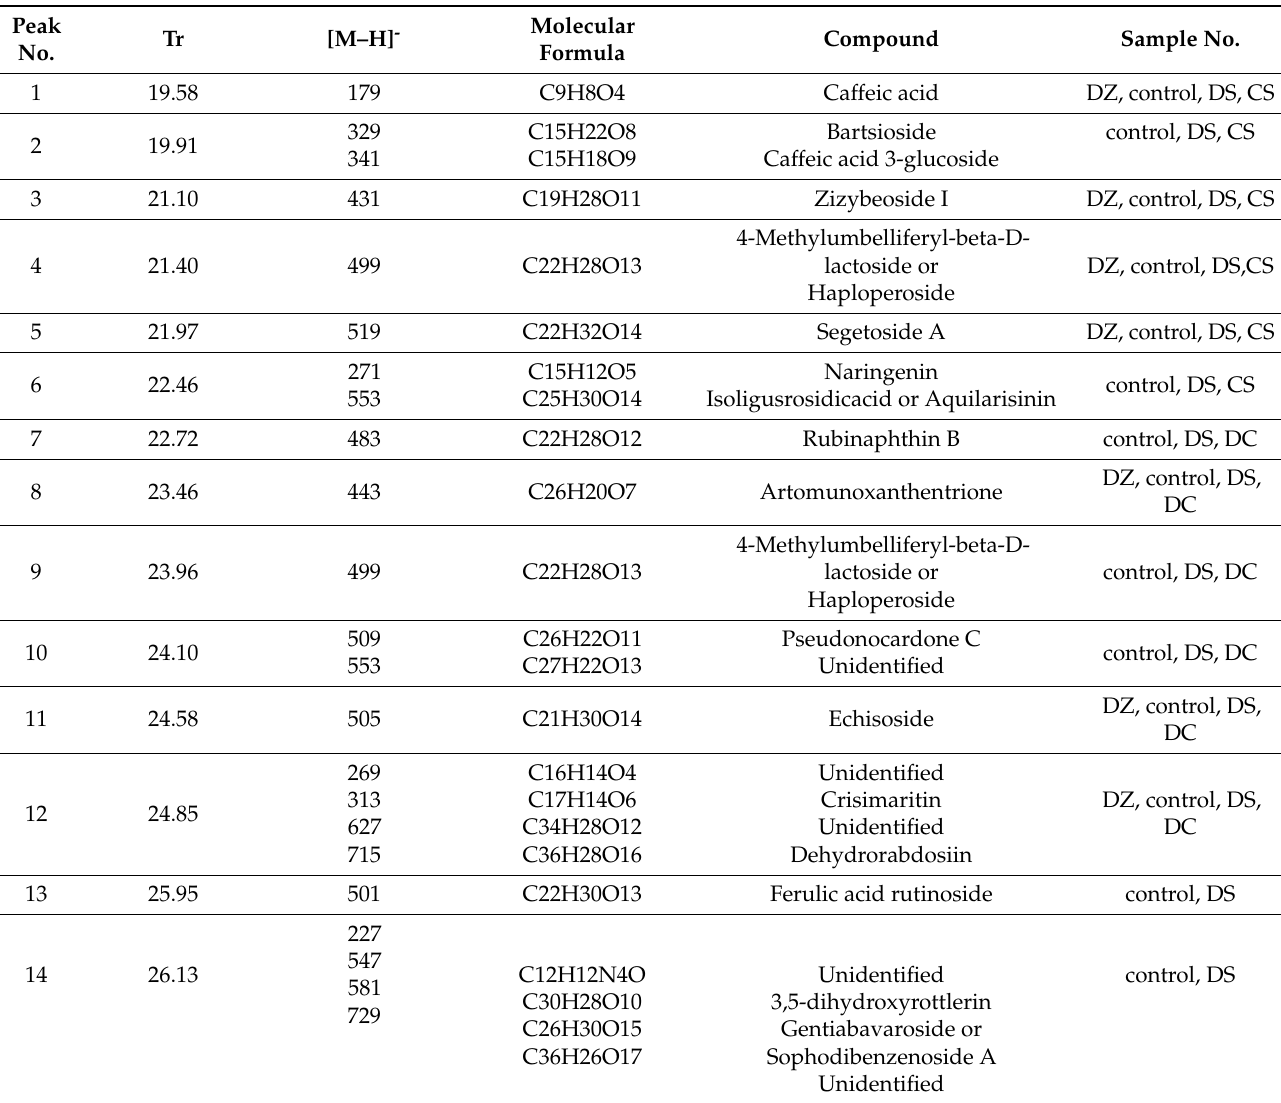
Table 7. HPLC-PDA-ESI-HRMS data on detected compounds in RgTR17 root extracts derived from various culture